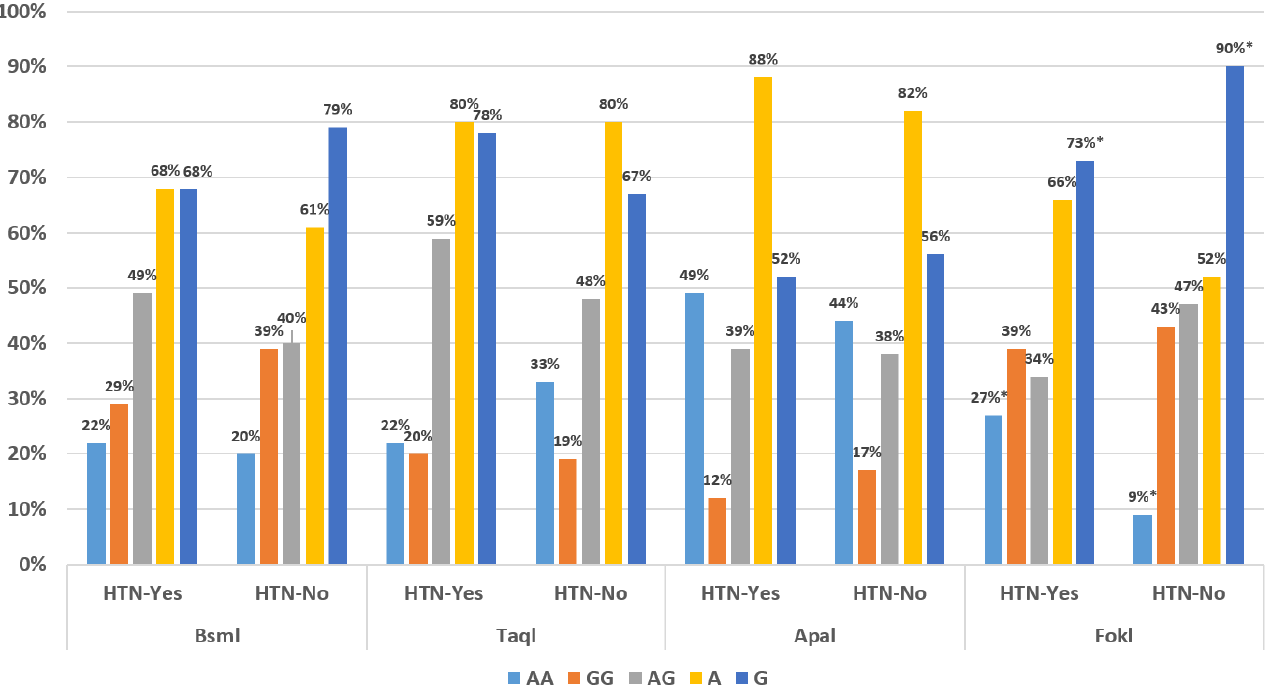
Figure 3. Genotypes and allele percentage distribution of four VDR gene polymorphisms in subject with hypertension (HTN-yes) compared with those without hypertension (HTN-No). * p <